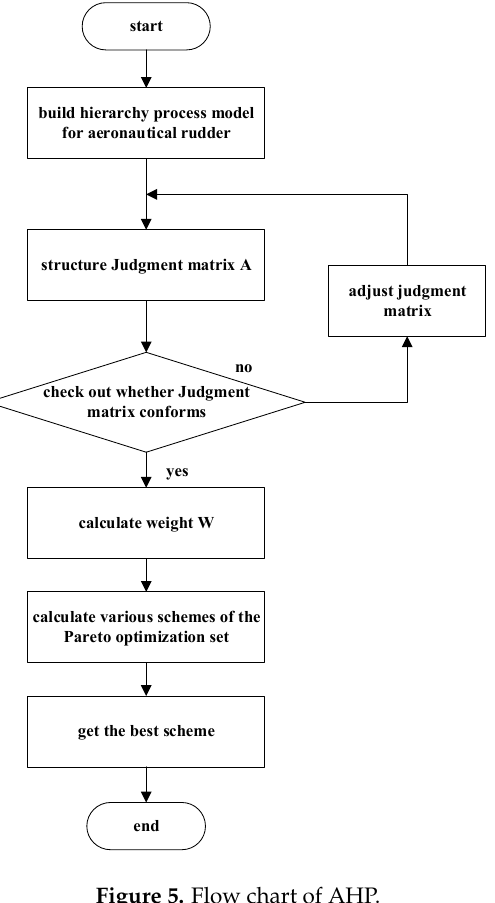
Figure 5. Flow chart of AHP. Table 1. Values of the average random consistence indicator.